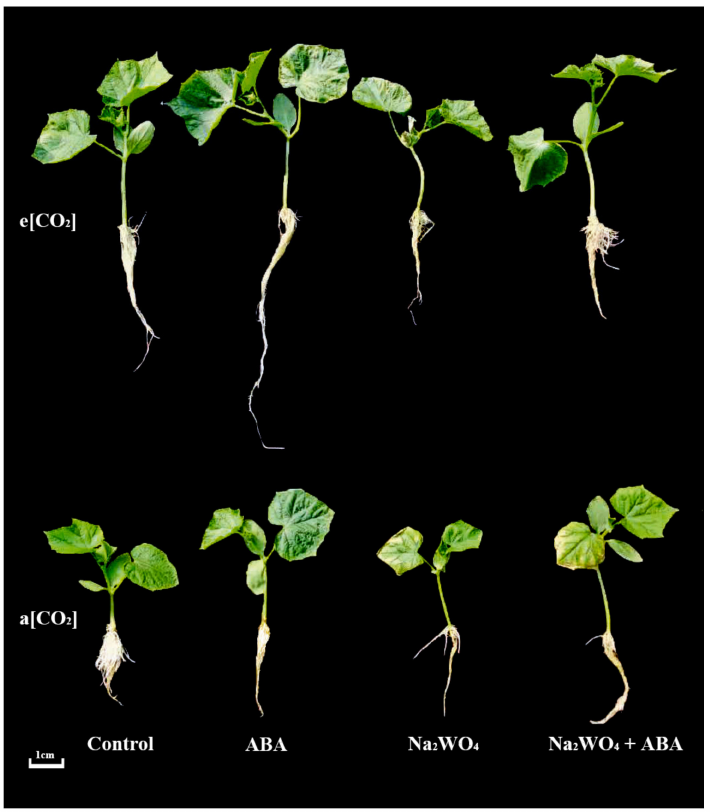
Figure 1. Side view of cucumber seedlings on day 5 under different